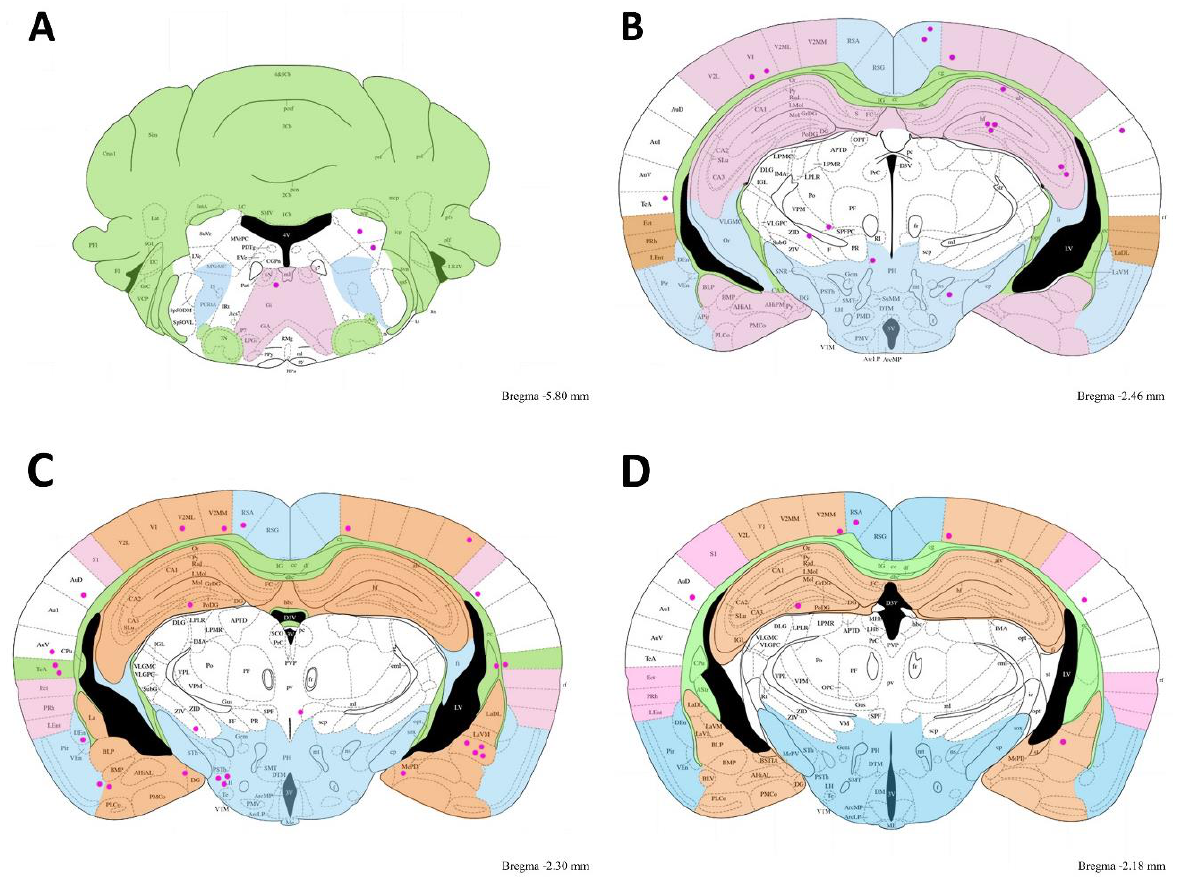
Figure 6. Brain schematic representing the cyst distribution in the mouse 7 from bregma − 1.94 to 1.34. The cuts are from a bregma distance indicated in the Figure in small leter in the right corner of each cut. Cysts are pink dots. Note cyst groupings found in the hippocampus, temporal and auditory cortex, amygdaline nucleus and hypothalamus.